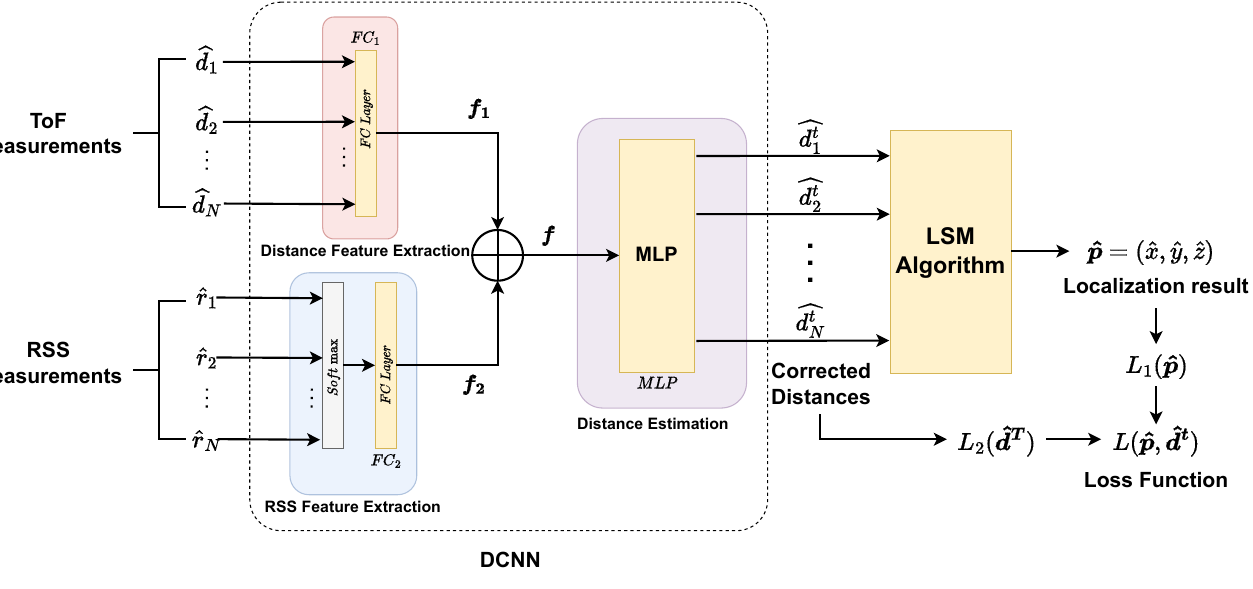
Figure 3. The architecture of the NN-LCS